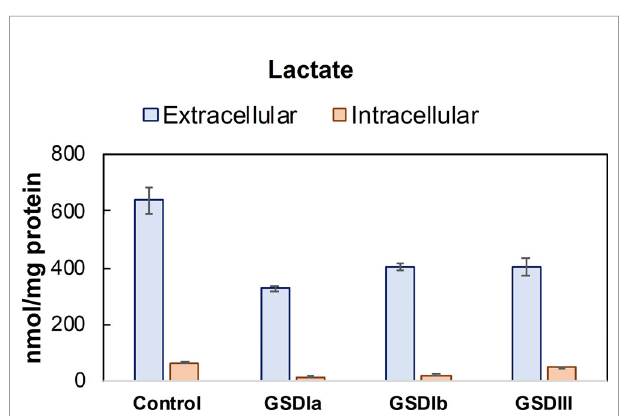
FIGURE 5 | Lactate concentration in conditioned culture medium (extracellular) and cell lysates (intracellular). Lactate concentration determined in conditioned culture medium and cell lysates after 5 days in culture. Lactate concentration was determined by LC-MS/MS and normalized by total protein concentration. Control: n=2; GSDIa n =1; GSDIb n=1; GSDIII n=3, each by triplicate. Data are shown as mean ± standard deviation. Intracellular lactate was signi fi cantly reduced in GSDIa and GSDIb compared to healthy controls, in contrast to GSDIII that exhibited lactate concentration comparable to controls (individual comparisons, one-way ANOVA, p < 0.05). A comparison of extracellular lactate from healthy control cells versus all GSD cells did not result in statistically signi fi cant differences.